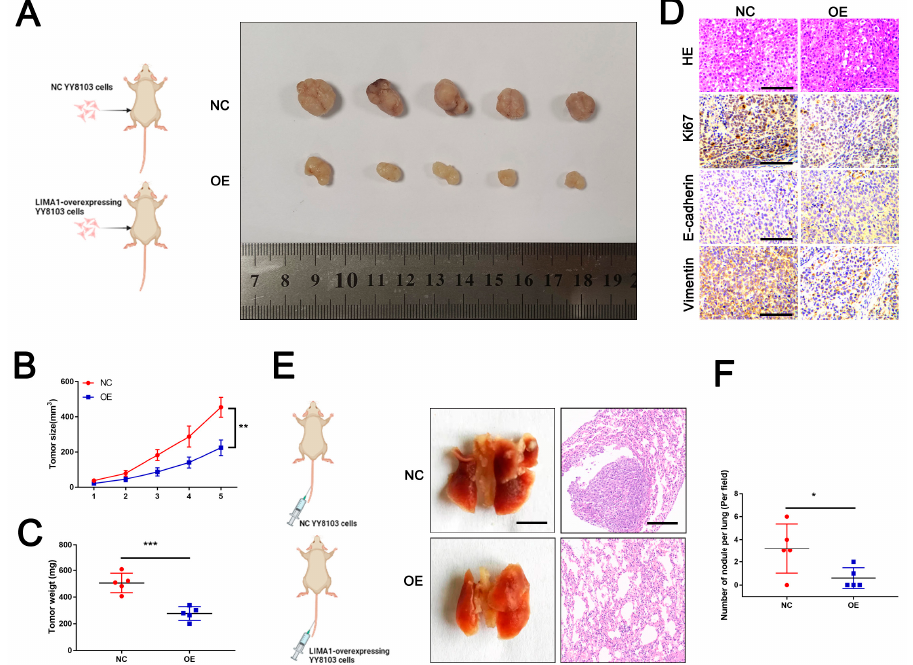
Figure 3. LIMA1 suppresses HCC progression in vivo. ( A ) The growth of tumours in the NC injection and LIMA1-OE groups was recorded every five days. ( B ) Tumours removed from mice injected with NC cells and LIMA1-OE cells after five weeks are displayed. ( C ) The tumour weight in the NC injection and LIMA1-OE groups was recorded. ( D ) HE staining and IHC for Ki67, E-cadherin and Vimentin were performed to detect the effects of LIMA1 on proliferation and EMT in vivo. The metastatic nodes in the lung were observed, confirmed by HE staining ( E ) and quantified ( F ). (NC, normal control; OE, LIMA1 overexpression). * p < 0.05, ** p < 0.01, *** p < 0.001.